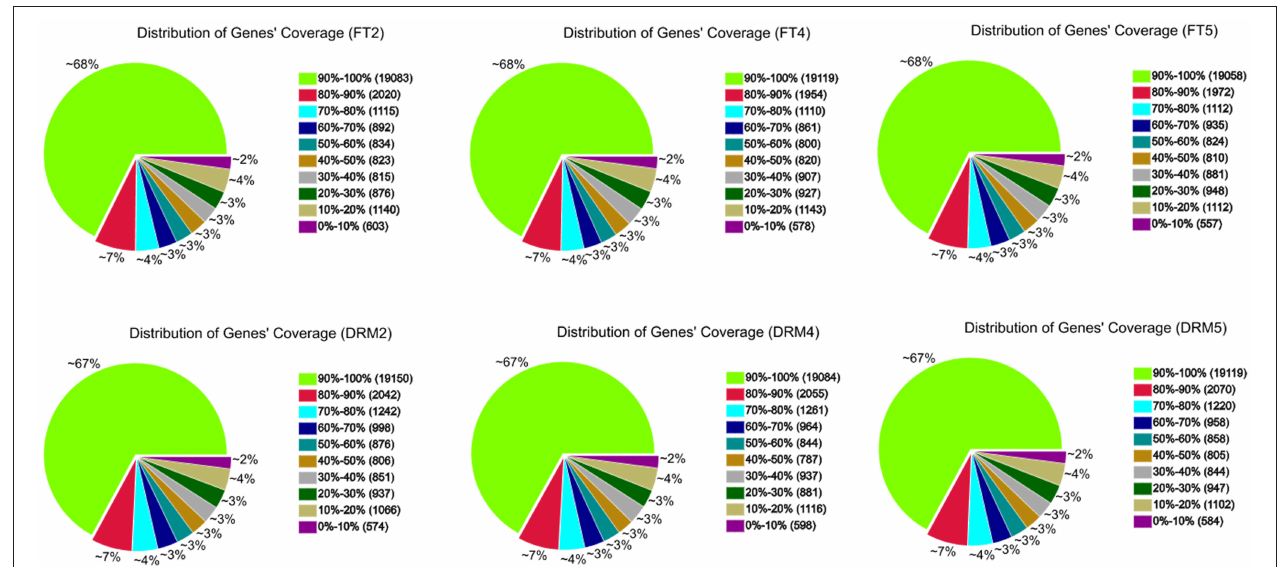
FIGURE 5 | Gene coverage of drm and wild-type “FT” mapped to the reference genome. Results are shown as the percentage of the total number of genes.